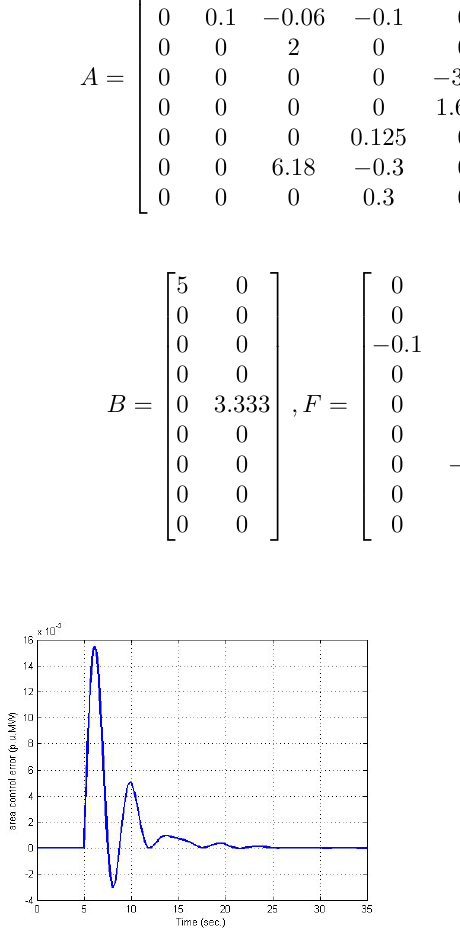
Case 2: In Case 1, the two-area power system is operated with all the parameters on their nominal values without considering parameter uncertainties. In real power system, parame- ter uncertainties always exist because of the variations of internal and external conditions. In this case, we study the LFC problem of the two-area power system with load changes and parameter uncertainties by using the proposed observer output-feedback controller. The uncer- tain parameters in the two-area power system